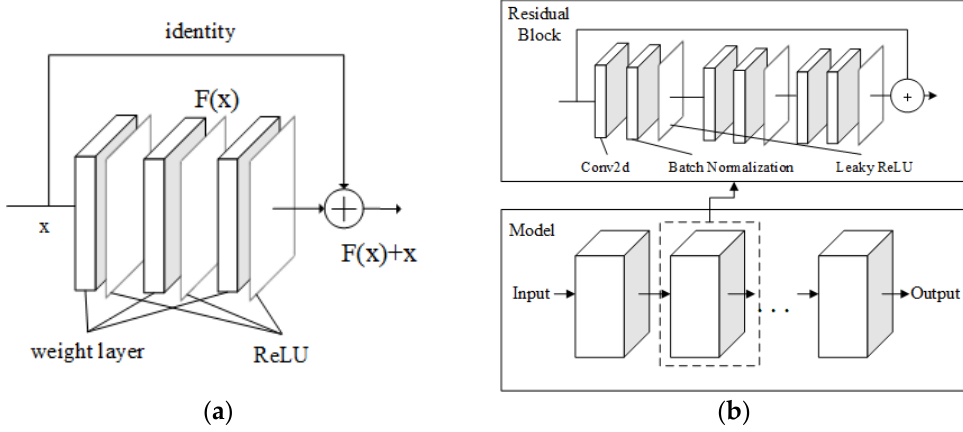
Figure 3. ResNet structure in SRE-ResNet framework. ( a ) Residual Learning, ( b ) SRE-ResNet.